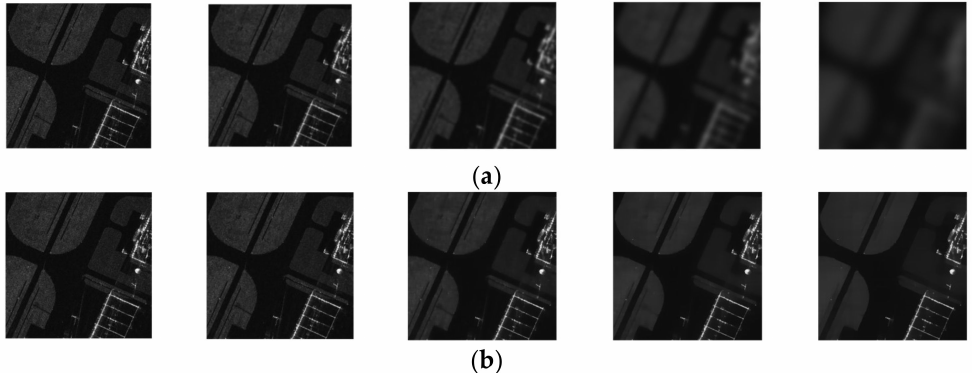
Figure 5. Results of nonlinear diffusion filtering and Gaussian filtering: ( a ) Gaussian filtering. ( b ) Nonlinear diffusion